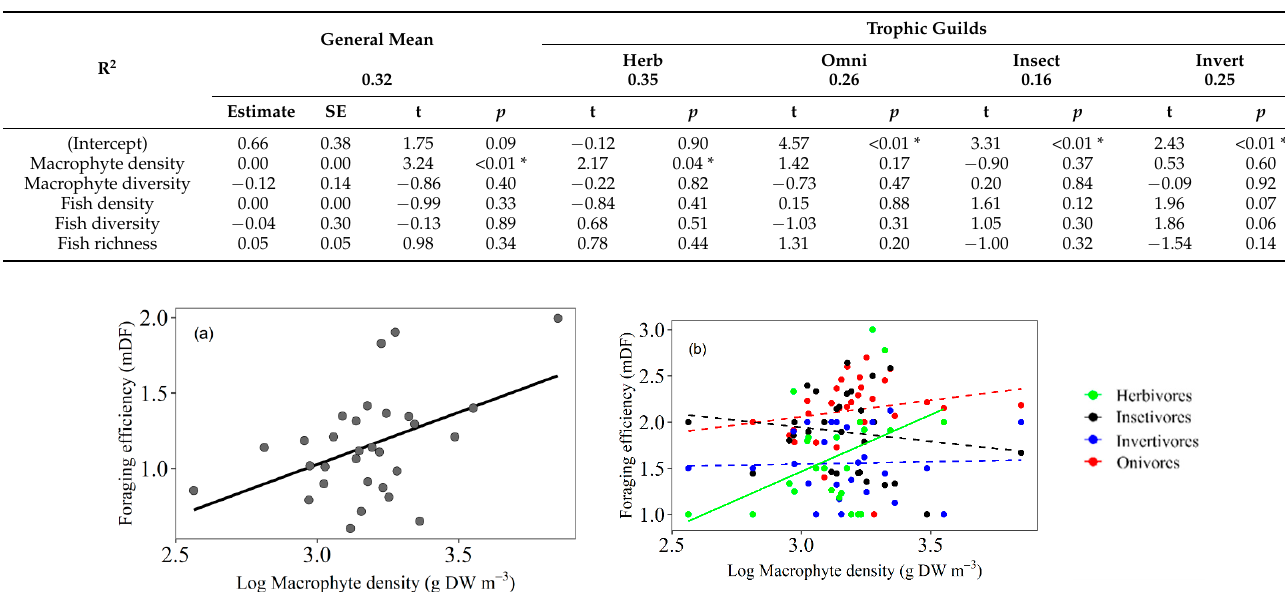
Table 1. Results of the generalized linear model for fish foraging efficiency assessed by degree of stomach fullness (mDF) considering a general mean and a mean calculated for each trophic guild separately. Herb = herbivores; Omni = omnivores; Insect = insectivores; Invert = invertivores. * = statistically significant values.